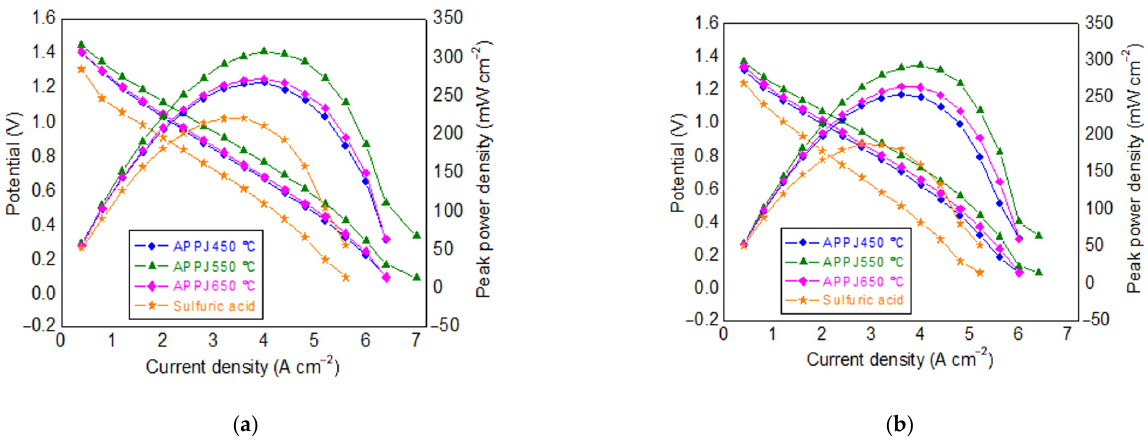
Figure 7. Performance curves of VRFB with GFs treated by various methods: ( a ) before cycling test; ( b ) after cycling test.